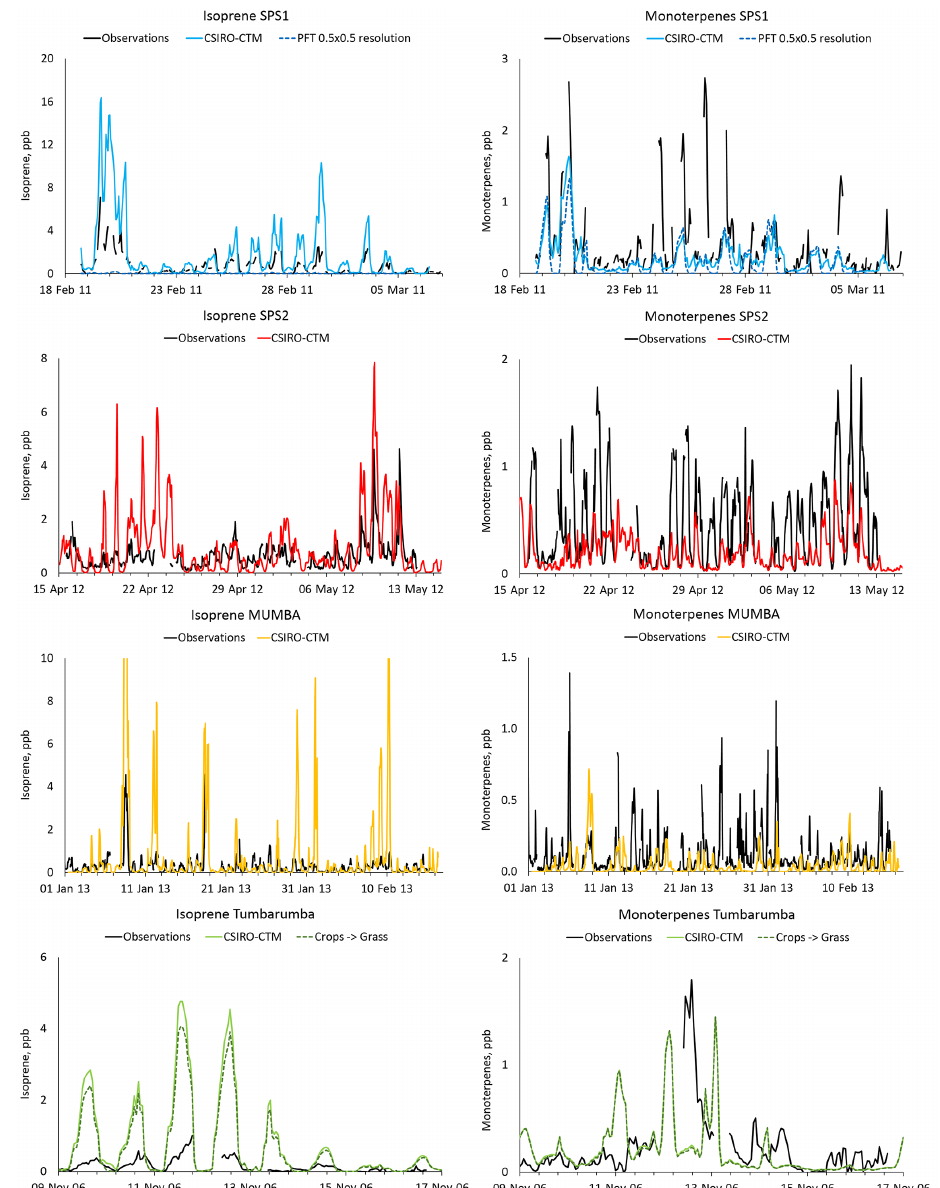
Figure 5. Time series of observed and modelled isoprene (left) and monoterpenes (right) for each field campaign. SPS1: blue; SPS2: red; MUMBA: yellow; Tumbarumba: green. The y axis for isoprene during MUMBA is restricted to 10ppb, as the modelled peak is 38ppb on 8 January